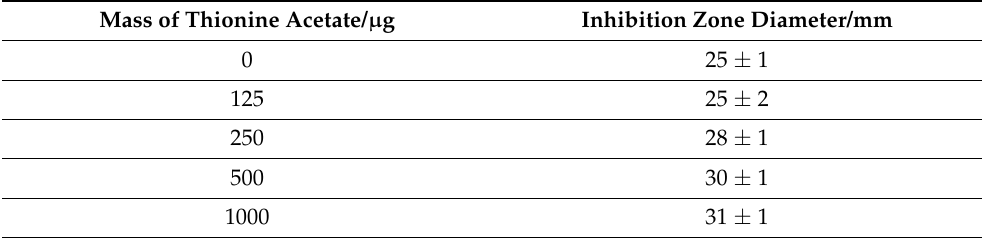
Table 1. Effect of thionine acetate on the inhibition zone diameter of ampicillin against E. coli . Mass of Thionine Acetate/ µ